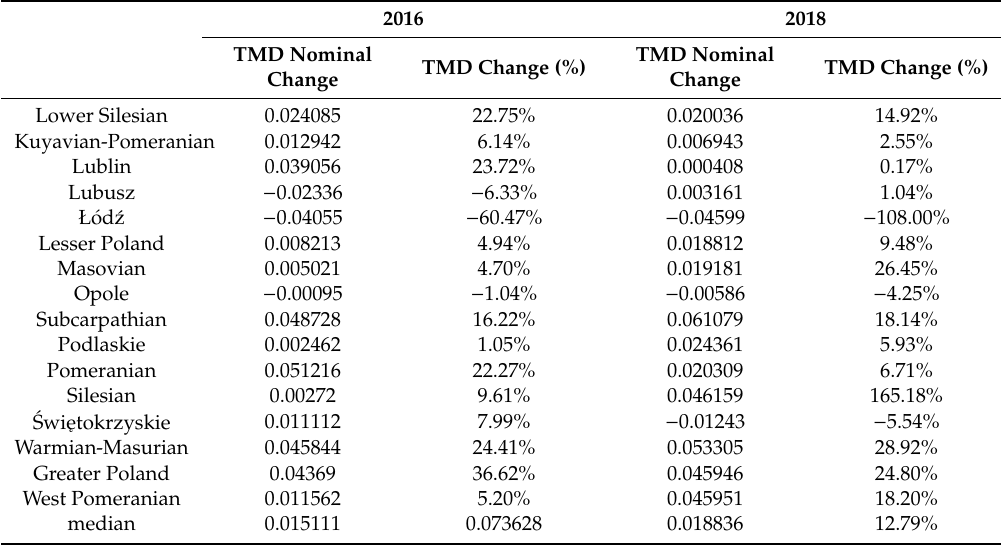
Table 6. Changes in the taxonomic measure of sustainable development following the removal of RES financing from the list of indicators (2016 and